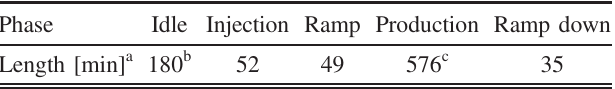
TABLE I. Time lengths assumed in the simulation for each successful phase in the operation